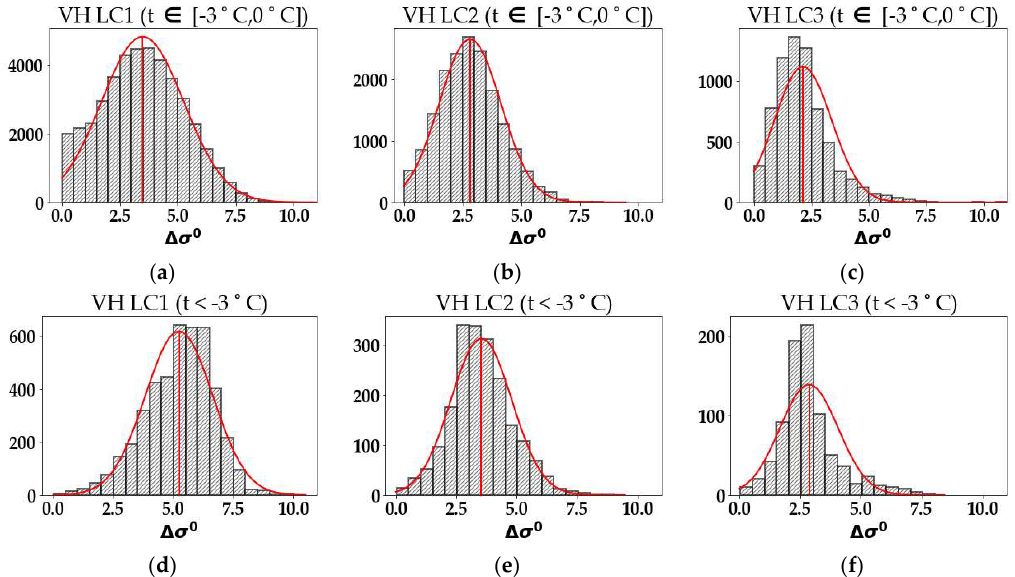
Figure 5. Distributions of ∆ σ 0 in VH polarization for the three main land cover classes: ( a , d ) cereals LC1, ( b , e ) meadows LC2, and ( c , f ) orchards and vineyards LC3. ( a , b , and c ) ∆ σ 0 over LC1, LC2, and LC3, respectively, for temperatures − 3 ◦ C ≤ t ≤ 0 ◦ C, ( d , e , and f ) ∆ σ 0 over LC1, LC2, and LC3, respectively, for t ≤ − 3 ◦ C. The Y-axis represents the frequency of different ∆ σ 0 ranges over the entire plots. The red curve represents the fitted normal functions, while the red vertical line represents the mean.